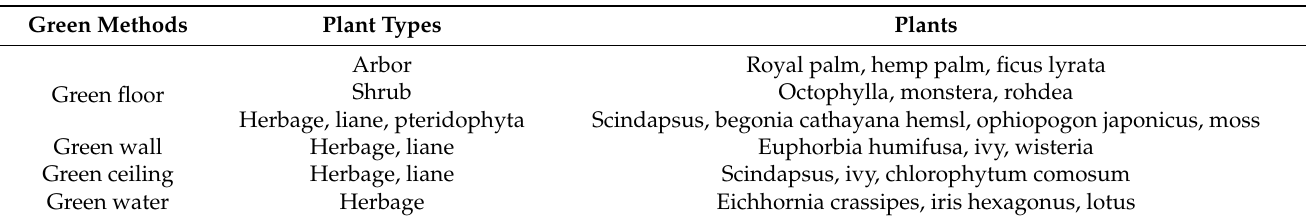
Table 9. Some plants suitable for underground